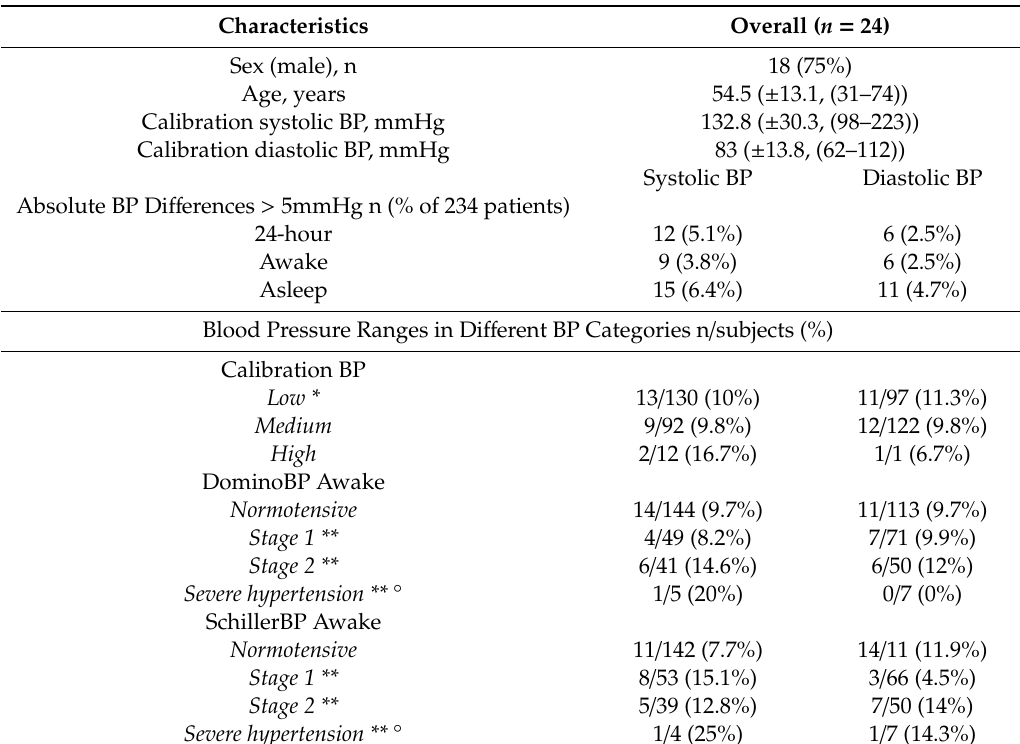
Table 8. Baseline characteristics for patients with an absolute systolic or diastolic blood pressure di ff erence of > 5 mmHg between data generated by DominoBP and SchillerBP software in 24-h, awake, or asleep blood pressure